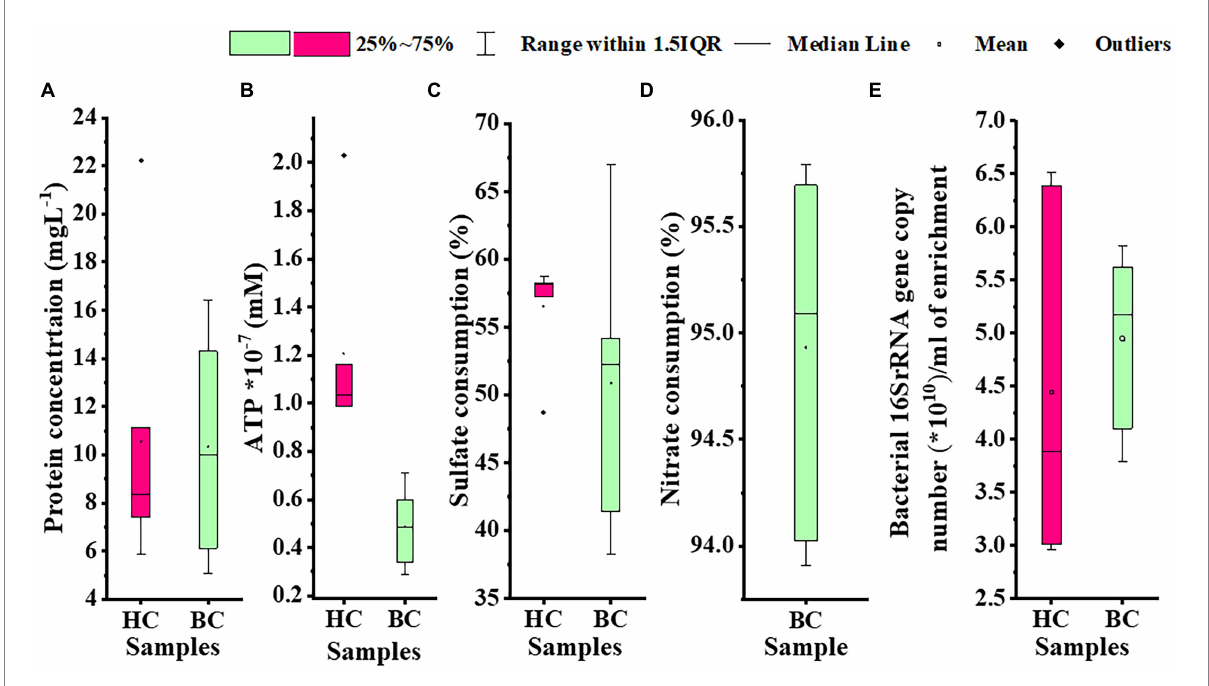
FIGURE 1 Assessment of (A) cell biomass in terms of total protein, (B) ATP, (C) utilization of sulfate; provided as TEA, (D) utilization of nitrate; as TEA, (E) Bacterial 16S rRNA gene copy number per mL of enrichment in HC and BC sets. The black center line denotes the median value (50th percentile), the empty square denotes the mean value and the pink (HC) and green (BC) boxes contain the 25–75th percentiles of the data sets. The values beyond these upper and lower boundaries are considered as outliers, marked with black filled diamond